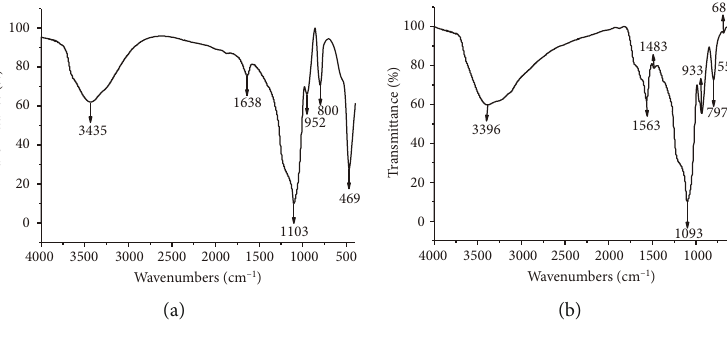
Figure 1: FT-IR spectra of (a) SiO